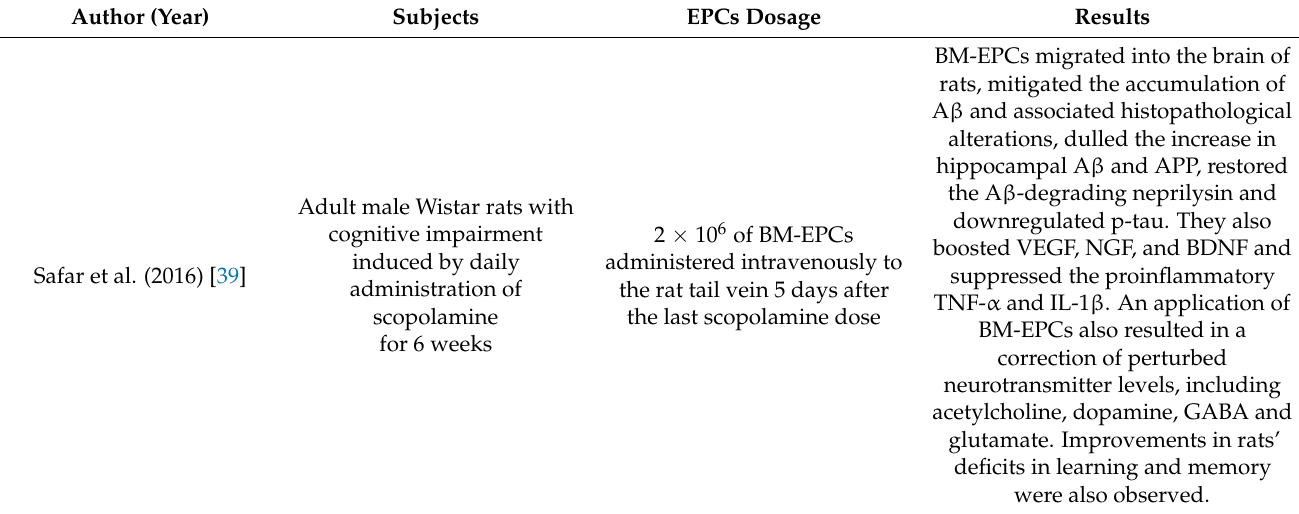
Table 2. A summary of studies on the use of EPCs in